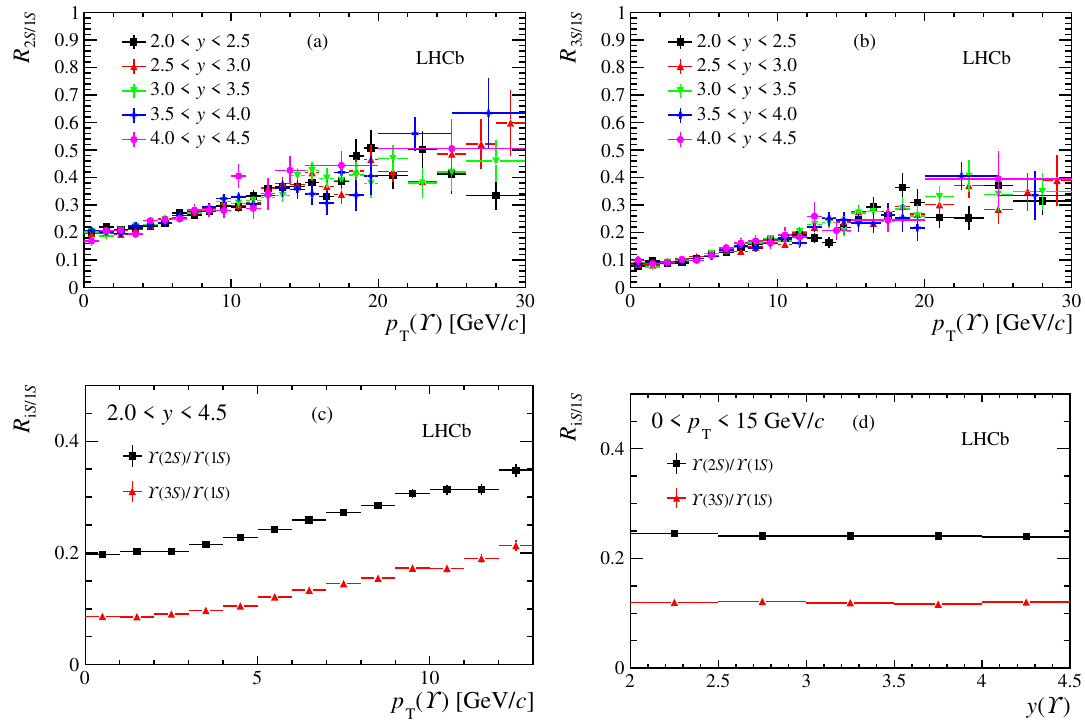
Figure 5 . Ratios of double-di(cid:11)erential cross-sections times dimuon branching fractions for (a) (cid:7) (2 S ) to (cid:7) (1 S ) and (b) (cid:7) (3 S ) to (cid:7) (1 S ). Ratios of di(cid:11)erential cross-sections times dimuon branch- ing fractions (c) versus p T integrated over y and (d) versus y integrated over p T for (cid:7) (2 S ) to (cid:7) (1 S ) (black solid squares) and (cid:7) (3 S ) to (cid:7) (1 S ) (red upward triangles). Statistical and systematic uncertainties are added in